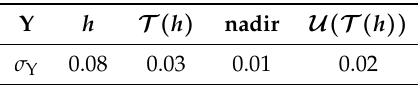
Table A1. The values of σ Y defining the observation error covariance matrices R = diag( σ 2 for the respective observations